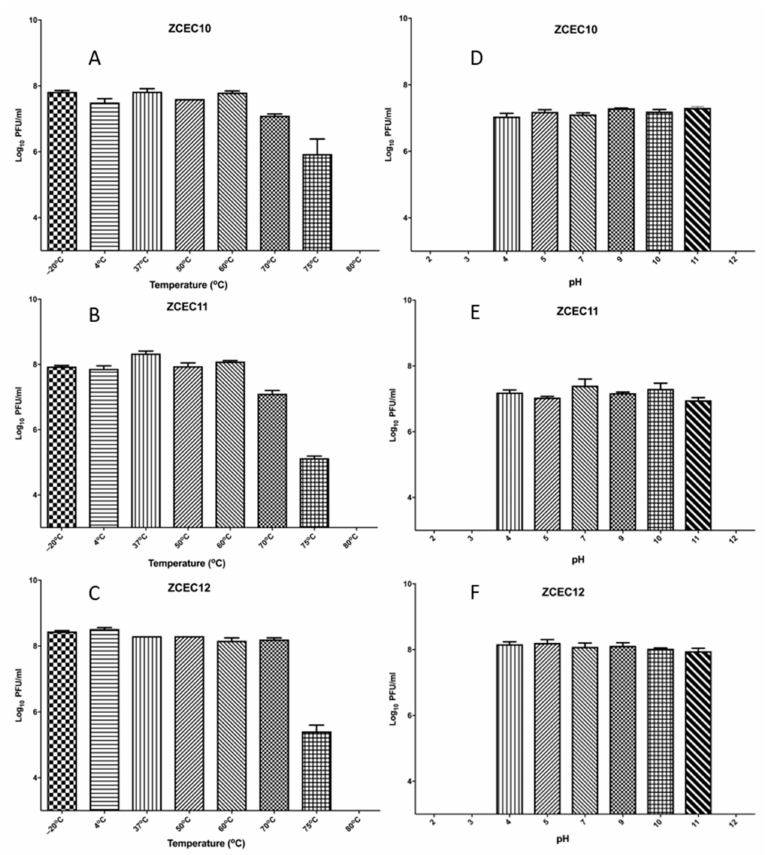
Figure 1. Stability of ZCEC10, ZCEC11, and ZCEC12 at different pH and temperatures. The figure represents the stability of phages at different temperatures: ( A ) ZCEC10, ( B ) ZCEC11, and ( C ) ZCEC12 and the stability of phages at different pH values: ( D ) ZCEC10, ( E ) ZCEC11, and ( F )